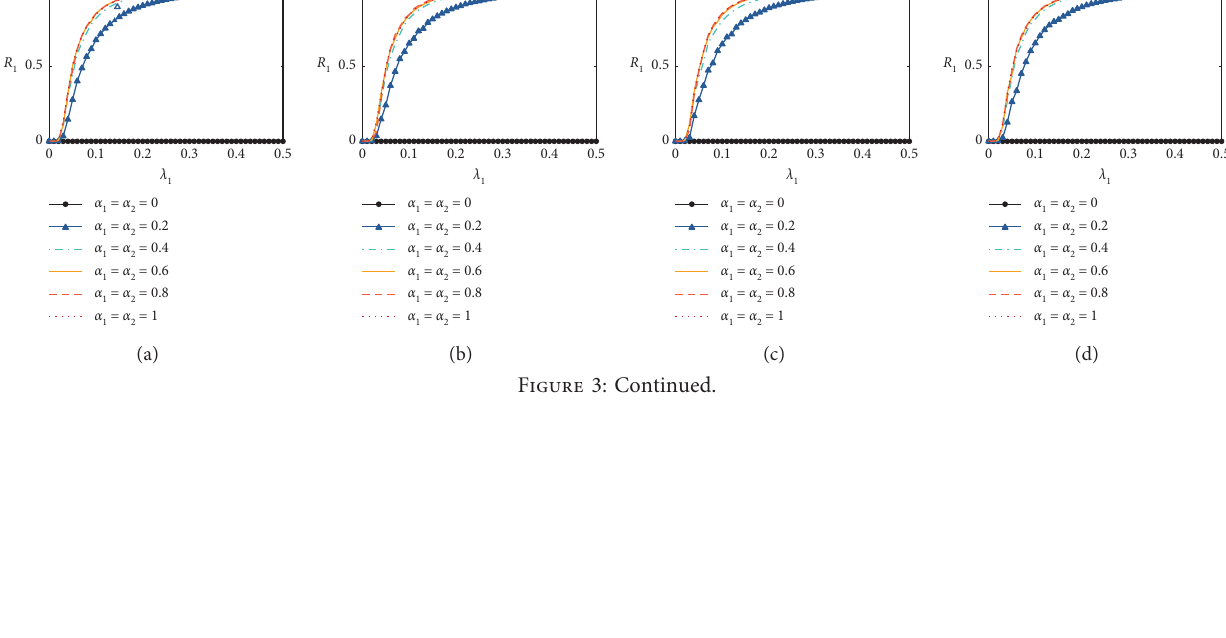
Figure 2: Virus spreading size R with (a) λ parameters are set to be c